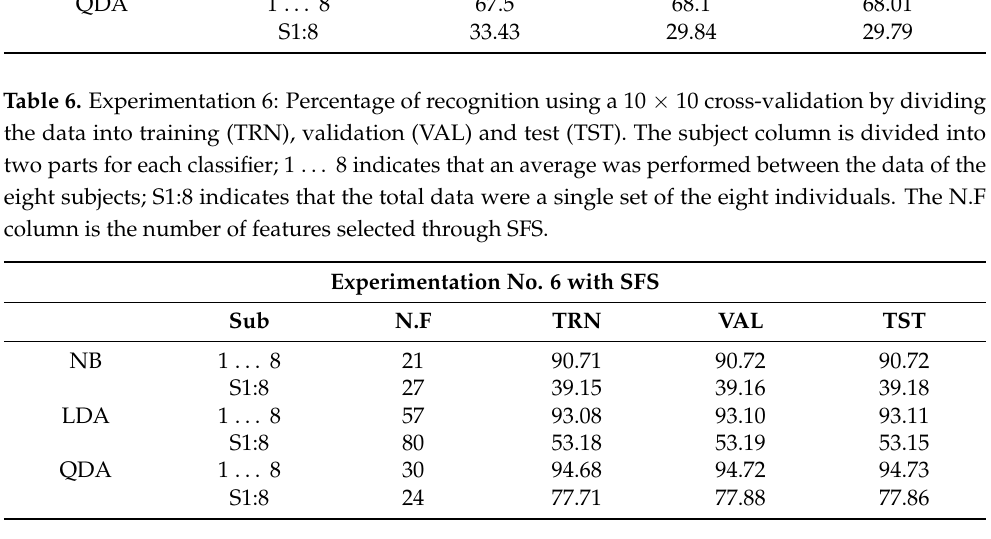
Table 7. Experimentation 7: The format of the table is the same as Table 5, with the total number of features used in the tests; normalization was applied to the data before they were used to create the model.